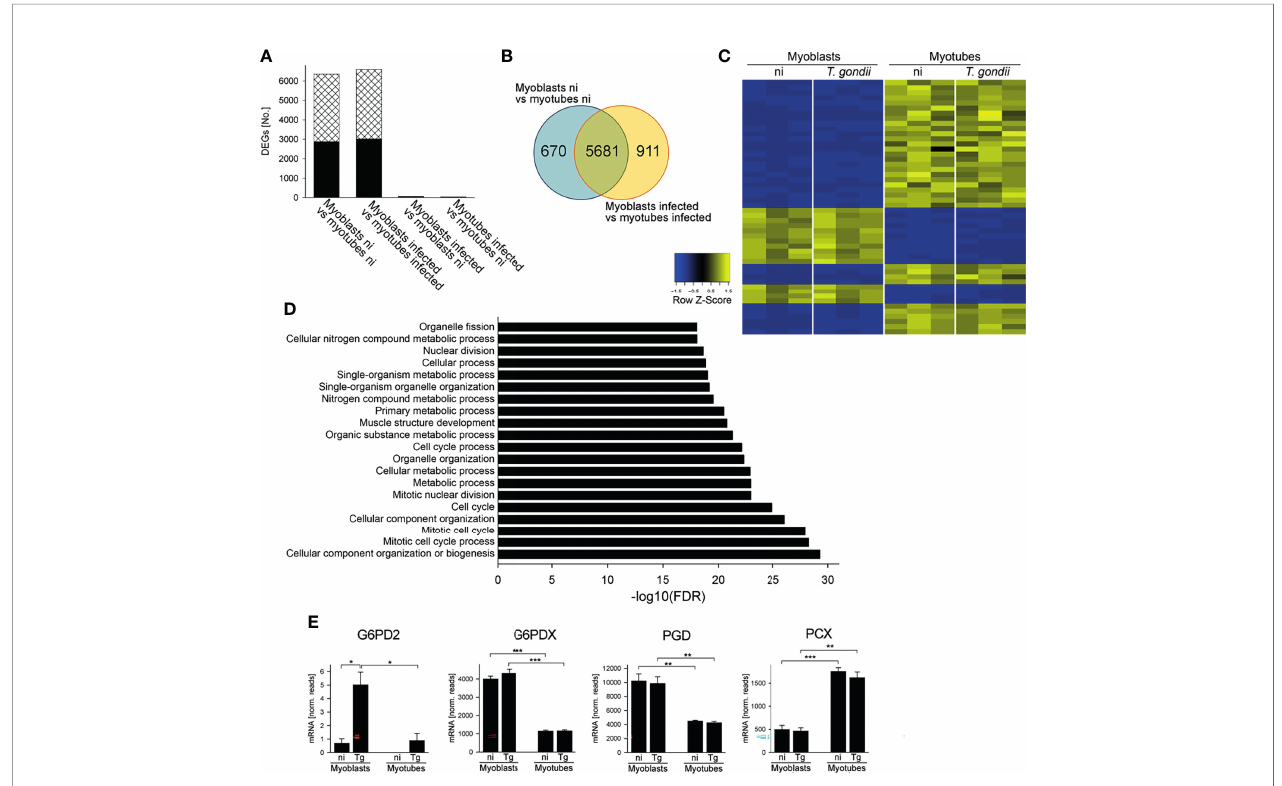
FIGURE 1 | Myoblasts and myotubes during infection with T. gondii diverge in their transcriptome pro fi les including multiple mRNAs of carbohydrate metabolic enzymes. C2C12 myoblasts and in vitro -differentiated C2C12 myotubes were infected with T. gondii at a MOI of 5:1 for 24 hours or were left non-infected. Total RNA from three biological replicates each was used to prepare cDNA libraries which were then sequenced using Illumina technology. Reads were mapped to the Mus musculus reference genome. (A) Numbers of differentially expressed genes (DEGs; p adjusted < 0.05) which were up- or down-regulated (black bars and cross-hatched bars, respectively) between myoblasts and myotubes or after infection as indicated. (B) Venn diagram of total DEGs identi fi ed between myoblasts and myotubes that were either non-infected (ni) or T. gondii -infected. (C) The top 50 genes that were most signi fi cantly regulated between infected myoblasts and myotubes were hierarchically clustered. Their expression levels from three biological replicates each of non-infected (ni) and infected ( T. gondii ) myoblasts and myotubes were visualized in a heatmap. (D) DEGs identi fi ed between infected myoblasts and myotubes were functionally analyzed for enrichment of gene ontology (GO) terms. The 20 GO biological processes which were most signi fi cantly enriched are depicted. (E) Expression levels of G6PD2, G6PDX, PGD and PCX were extracted from the RNAseq data sets and are depicted as means ± S.E.M. from three biological replicates. Signi fi cant differences were identi fi ed by Student ’ s t -test (* p < 0.05; ** p < 0.01; *** p <